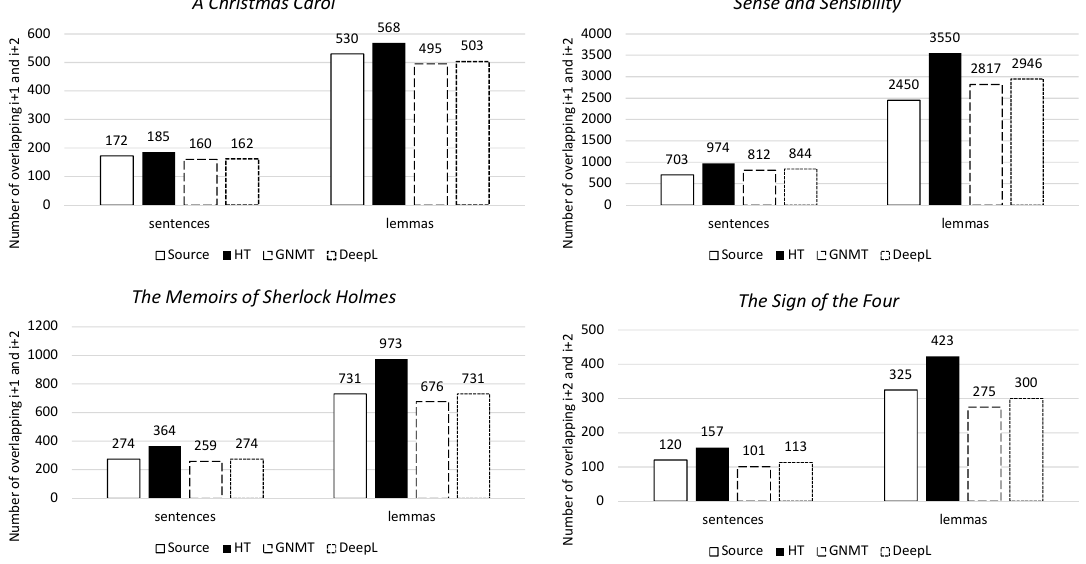
Figure 8. Lexical cohesion for i+1 and i+2 per novel, on both the sentence and lemma levels.